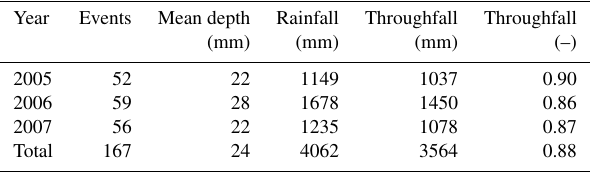
Table 1. Number of events sampled each year and corresponding rainfall and throughfall